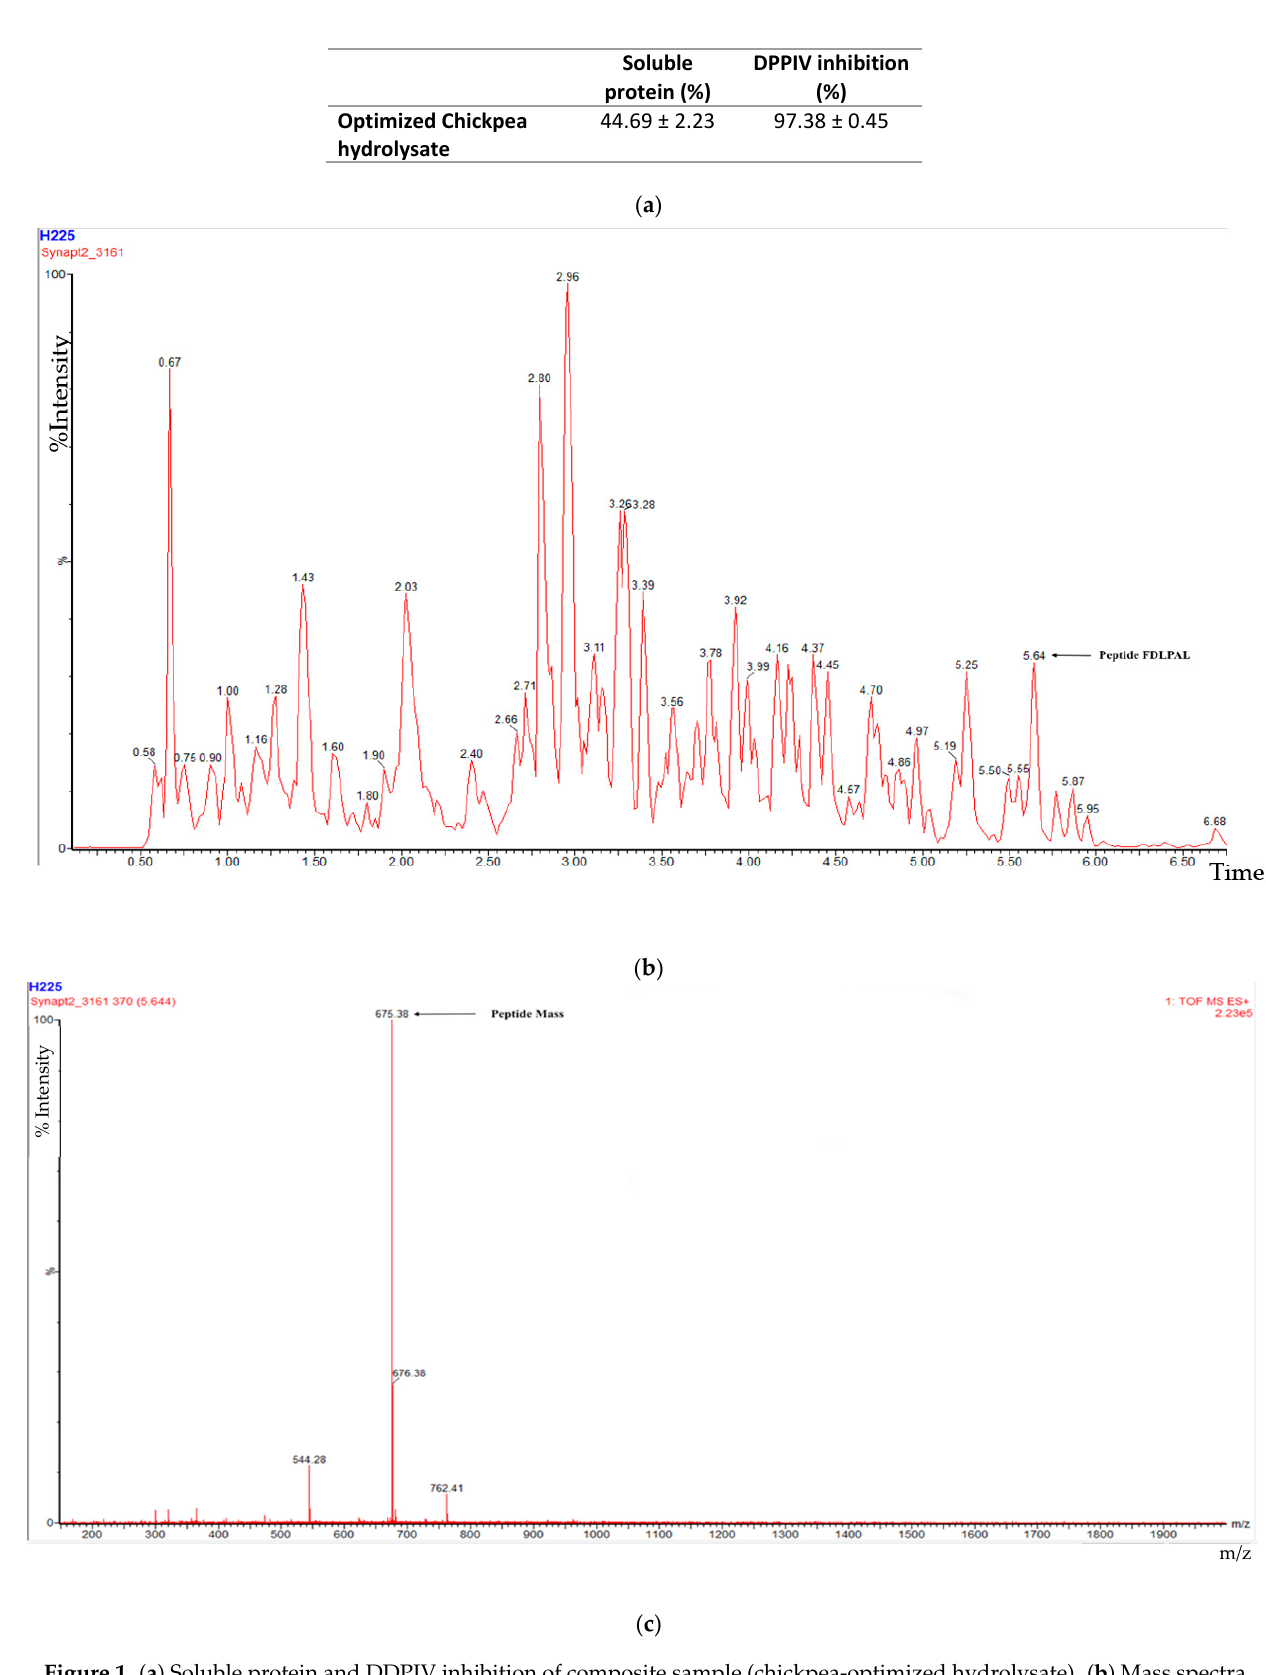
Figure 1. ( a ) Soluble protein and DDPIV inhibition of composite sample (chickpea-optimized hydrolysate). ( b ) Mass spectra indicating elution time. ( c ) Spectra showing peptide mass, and precursor ion M/z value of peptide